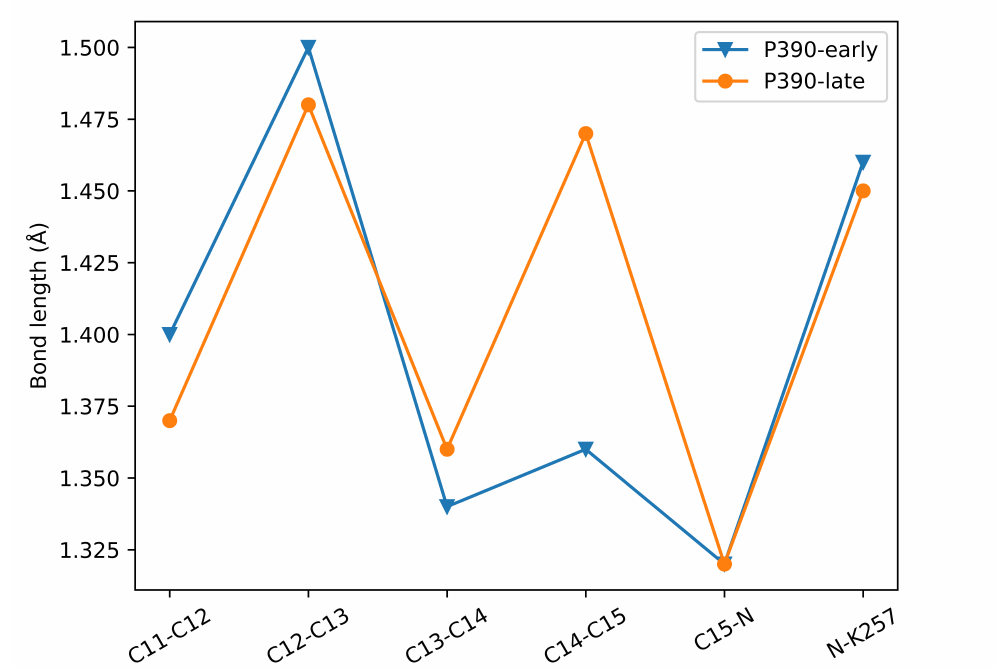
Figure 6. The partial bond length of retinal in P390-early and